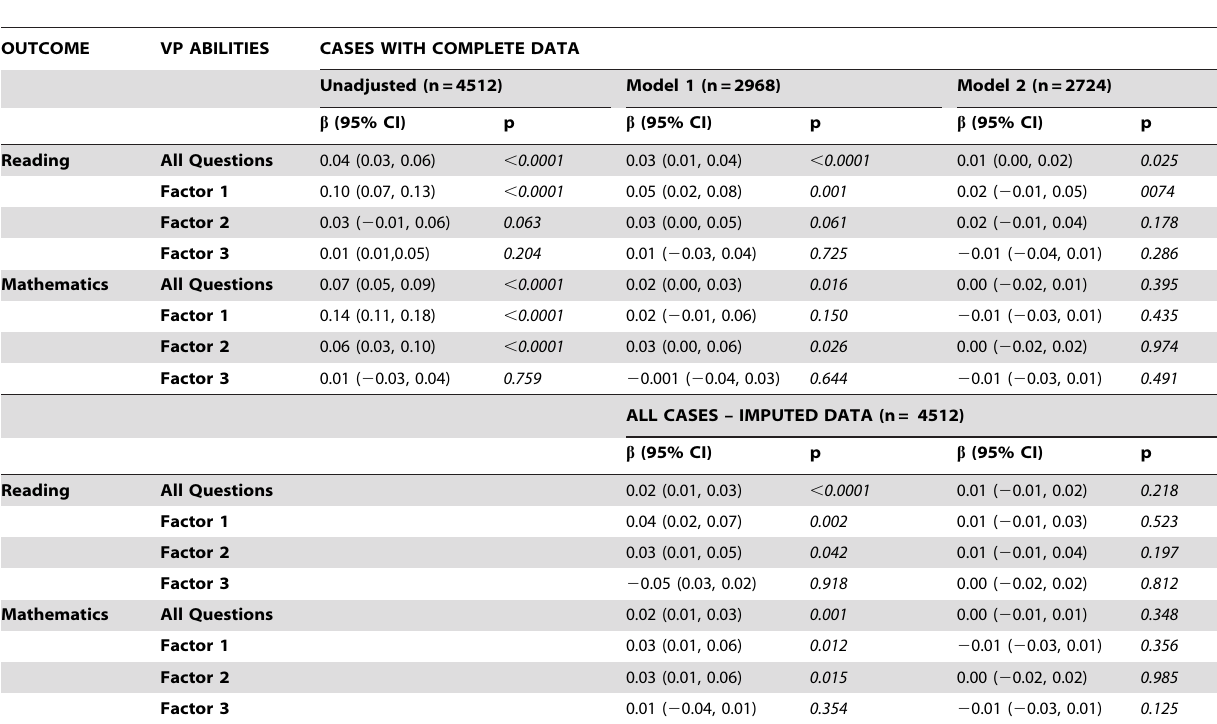
Table 3. Parameter estimates ( b ) for associations between VP abilities and school test results at 13–14 years in ALSPAC participants.